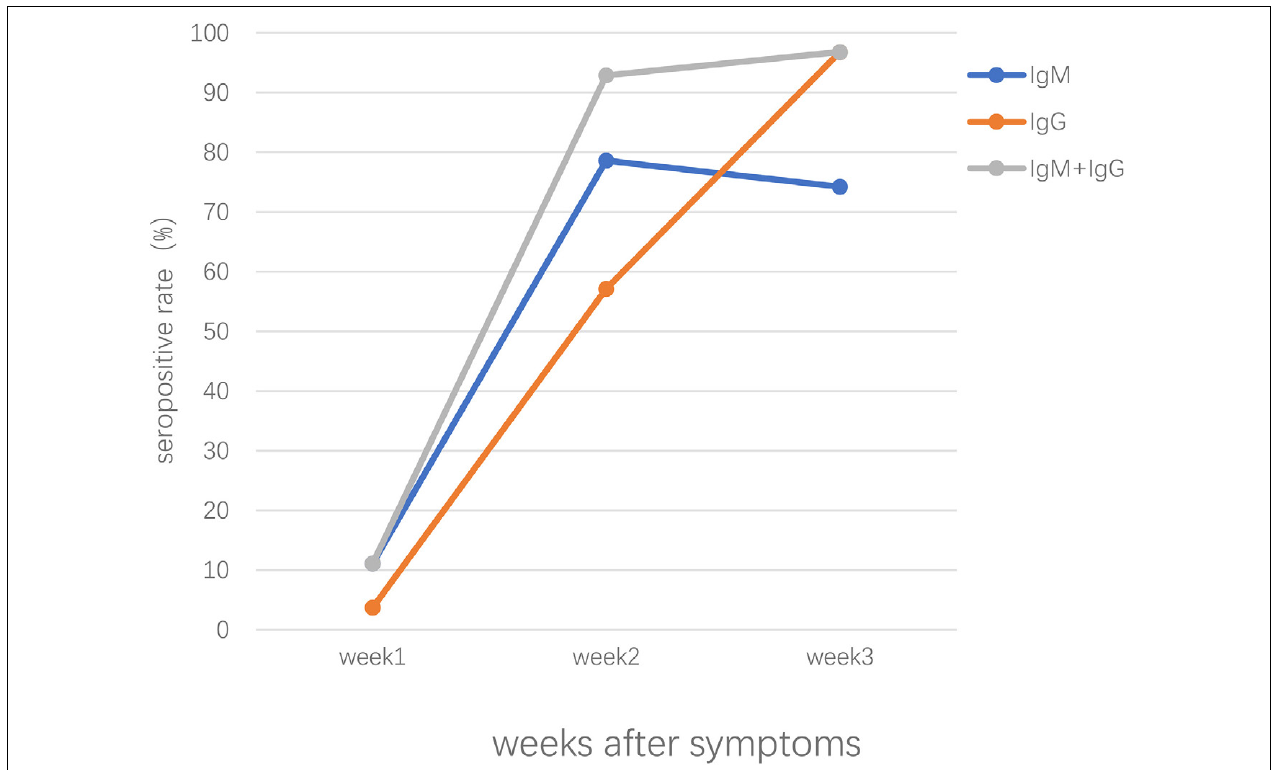
FIGURE 1 | The seropositive rates of specific IgM, IgG, the combination of IgM and IgG antibody response in patients confirmed with SARS-CoV-2 infection after symptoms onset.